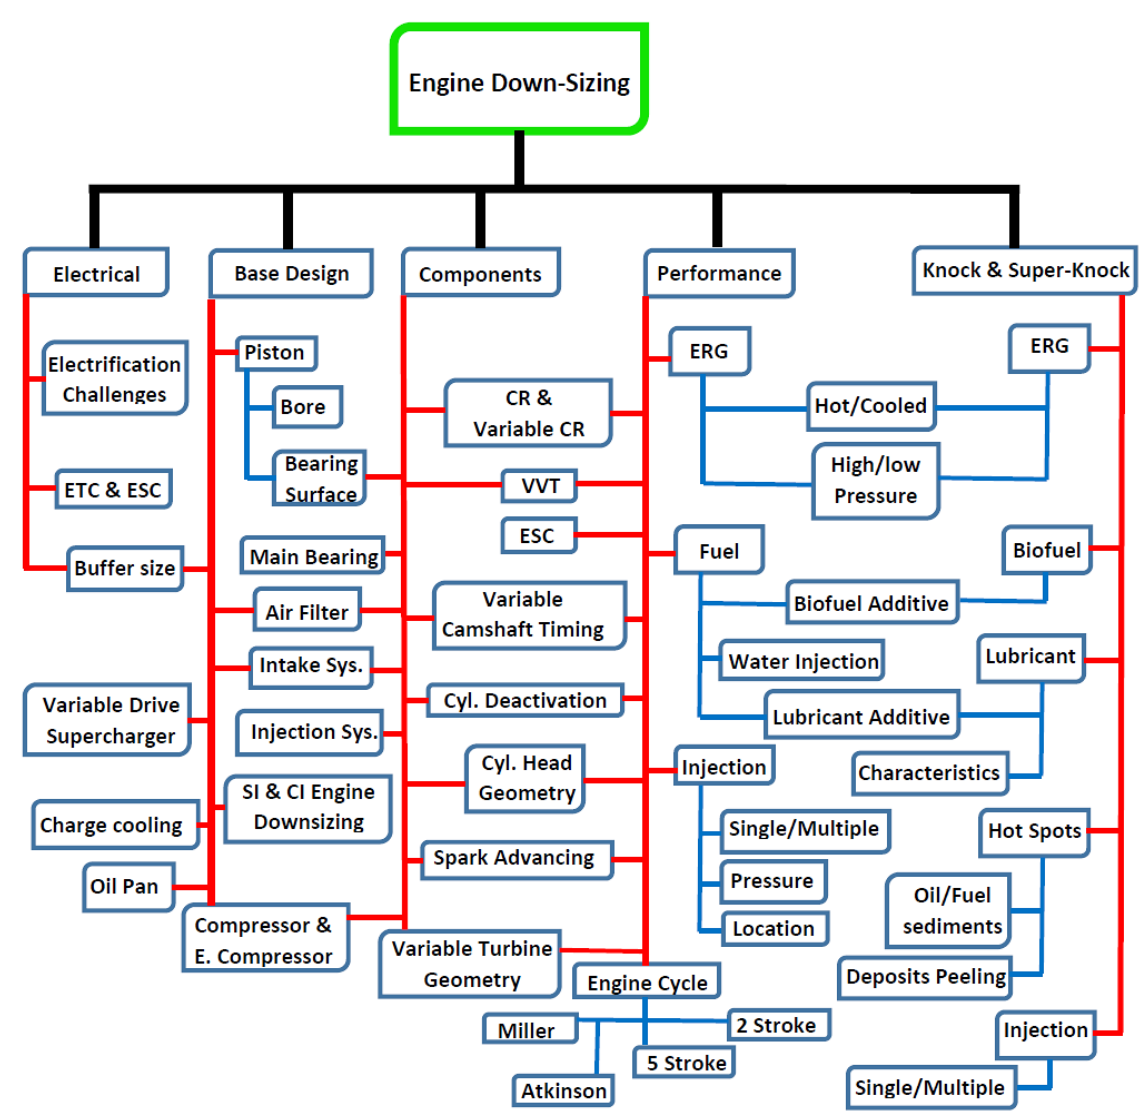
Figure 1. Strategies for downsized engines